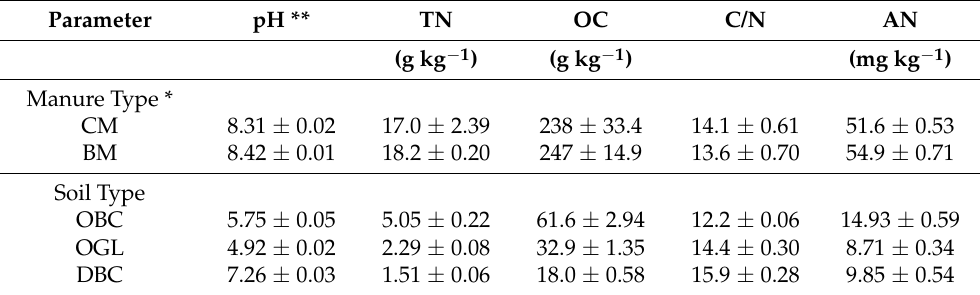
Table 1. Chemical properties of the soil and manure types used in the incubations (means ± SE) ( n = 3).